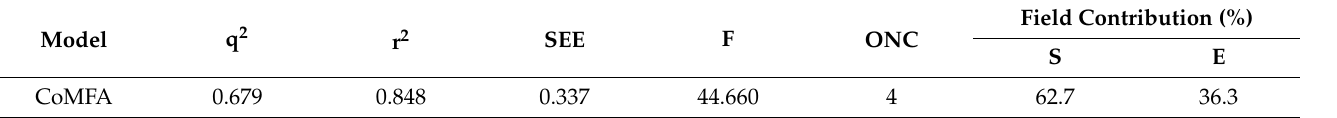
Table 3. Statistical result of the CoMFA model.